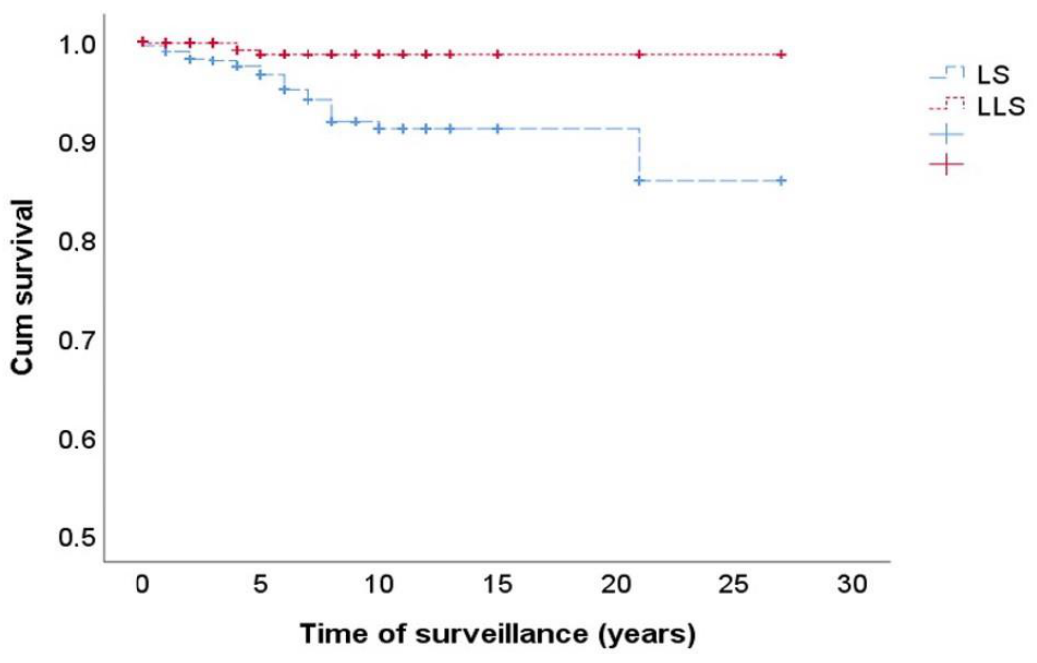
Figure 3. Kaplan–Meier curve showing the risk incidence of CRC and other LS-associated tumors during follow-up in the FDRs of patients with LS and LLS. Log Rank, p = 0.000.